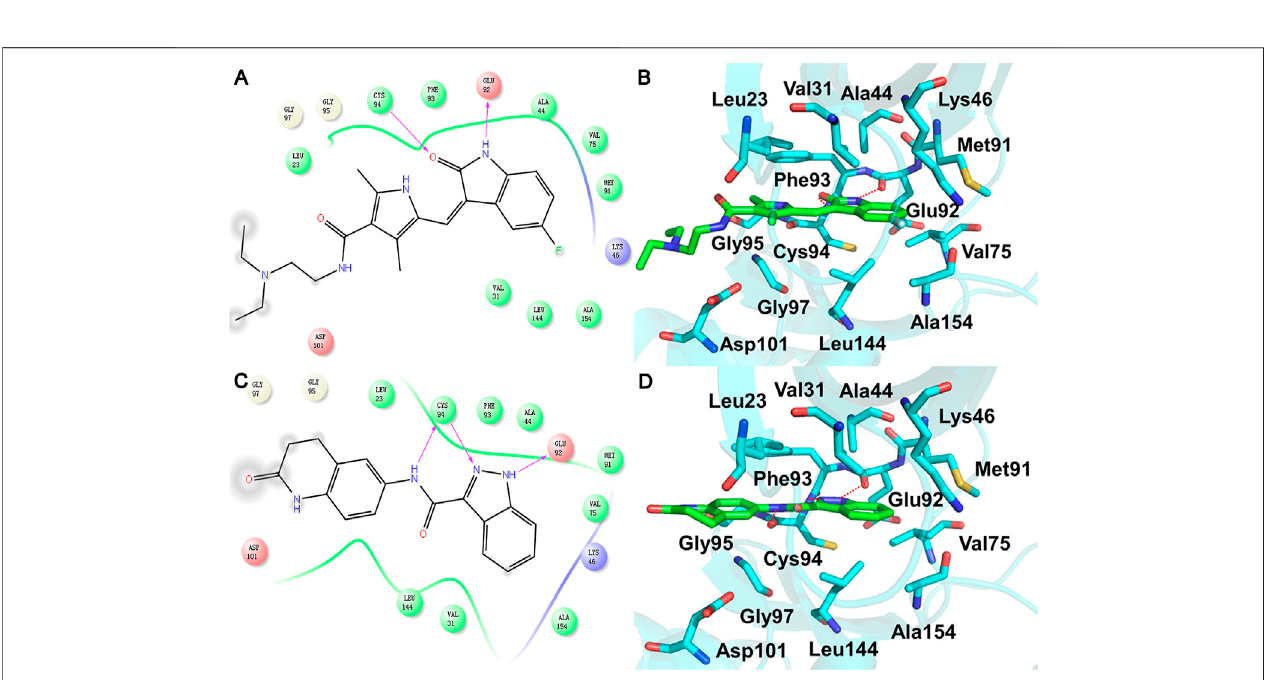
FIGURE4| 2DmodeldiagramofHPK1with (A) sunitiniband (C) compoundM074-2865andthe3DbindingmodeofHPK1with (B) sunitiniband (D) M074-2865. Theinhibitorsareshown asgreensticks,andthekeyresiduesofHPK1kinasebindingtoinhibitors areshownascyansticks.Thehydrogen bondbetweenHPK1 kinase and inhibitors is shown as a red dash.